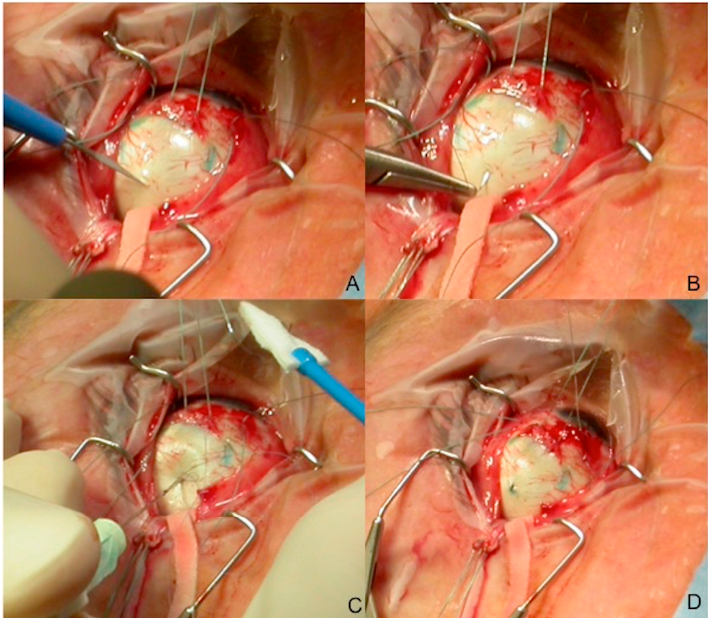
Figure 4. Fine needle aspiration biopsy sample: transscleral approach in a posterior uveal melanoma. Our standard fine needle aspiration biopsy (FNAB) procedure is performed using a 25 gauge (25 mm in length) spinal needle connected to a 10 cc syringe by a hollow tube. ( A ) The needle is inserted into the tumor trough a partial scleral incision (to avoid excessive pressure when penetrating the eye) (Figure 1). ( B ) The scleral suture (7.0 Polyglactin) is prepared before the needle insertion. ( C ) A double-pass or multiple-pass sampling is often performed through the same scleral access. ( D ) The scleral incision is then sutured and the radioactive plaque immediately placed over the tumor base.